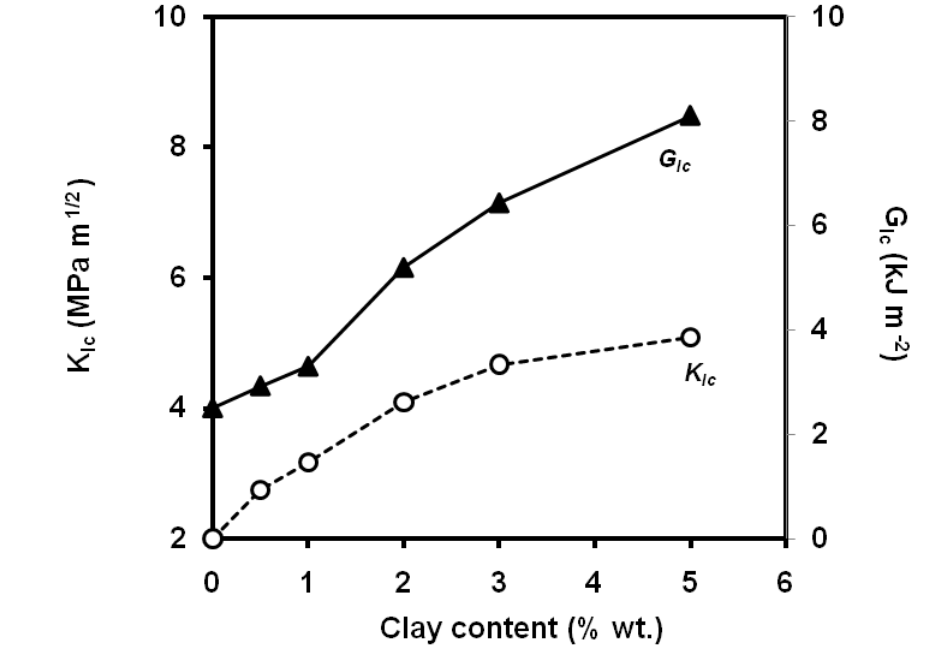
Figure 36. Influence of montmorillonite content on K from